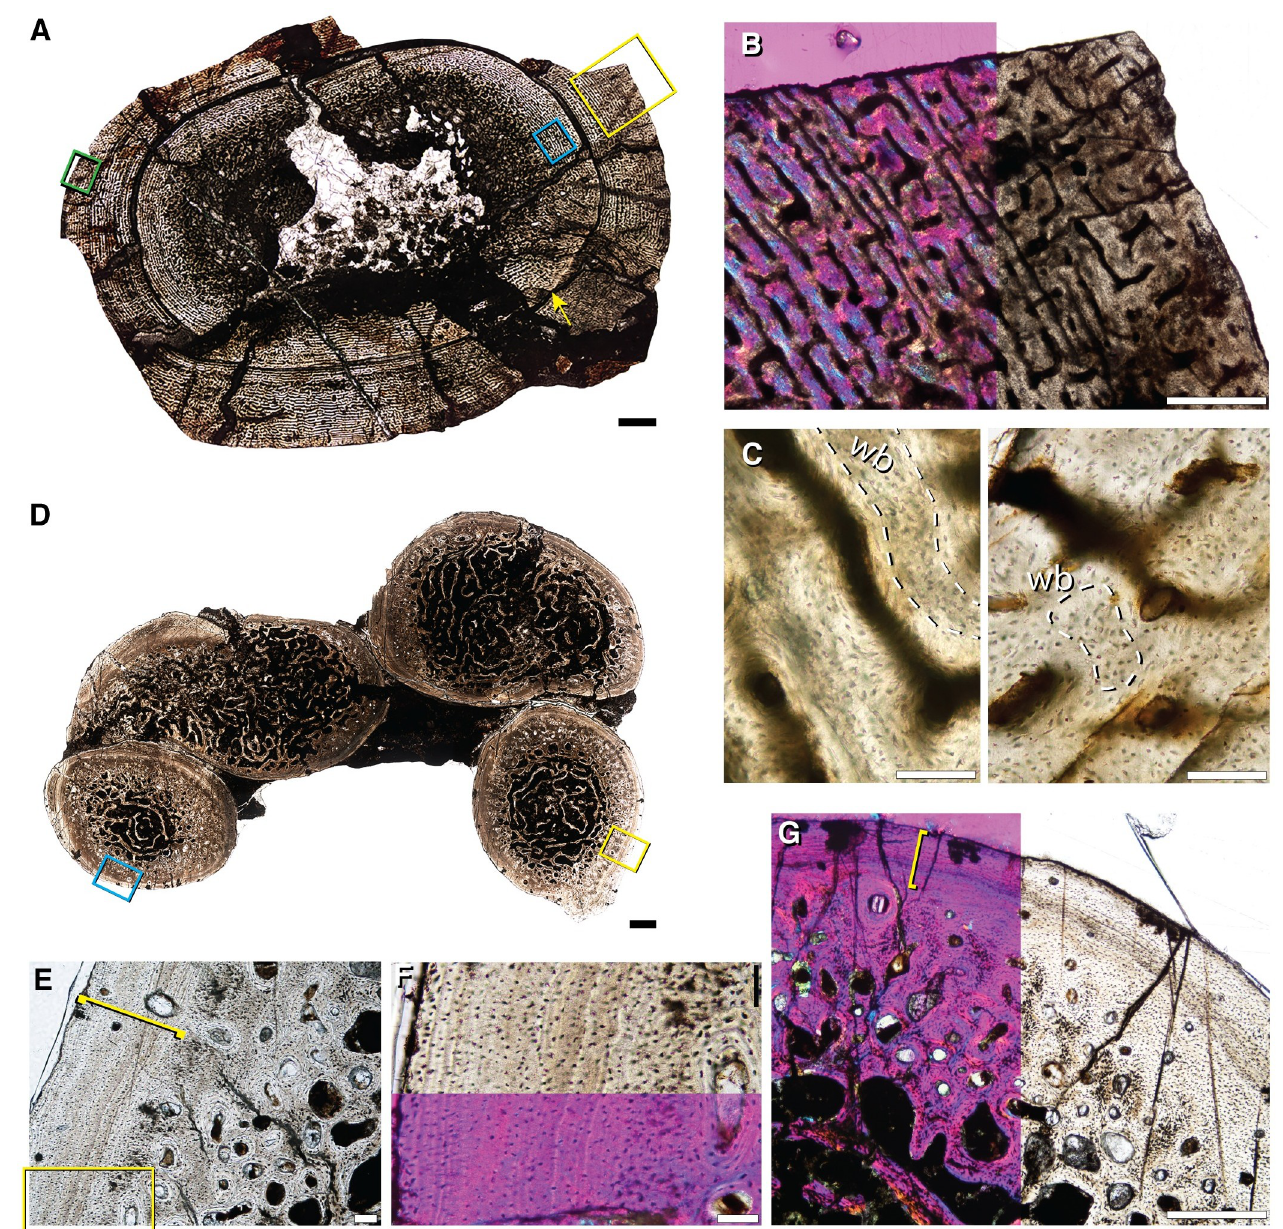
Fig 6. Bone histology of the largest femur (IVPP V 27127) of Lystrosaurus sp. that represents Size Class IV and rib fragments of unknown size. A , the femur is cracked (yellow arrow is a large circular crack) but preserves regions of the entire cortex (yellow box). B , magnification of yellow box in A using cross- polarized light with a lambda filter shows well-vascularized, plexiform tissue along the sub-periosteal margin. C , left panel shows woven-fibered bone in the deep-middle cortex (blue box in A ) and outer cortex, right panel (green box in A ). D , rib fragments (IVPP V 27124–5) have infilled medullary cavities, secondary osteons within the deep cortex and a largely avascular compact outer cortex consisting of organized parallel-fibered tissue. E , magnification of yellow box in D showing the peripheral parallel-fibered tissue in the yellow bracket. F , magnification of the yellow box in E under plane and cross-polarized light with a lambda filter. G , magnification of blue box in D similarly shows that peripheral parallel-fibered tissue is present (yellow bracket). wb = woven-fibered bone. Scale bars = 10 mm in A , 1 mm in D , 500 μ m in B & G , 100 μ m in C , E & F . of woven-fibered bone (Fig 6C). There is no indication of a transition to slowed bone deposi- tion in the small regions of sub-periosteal bone that remain intact, suggesting a sustained rate of growth at death (Fig 6B).